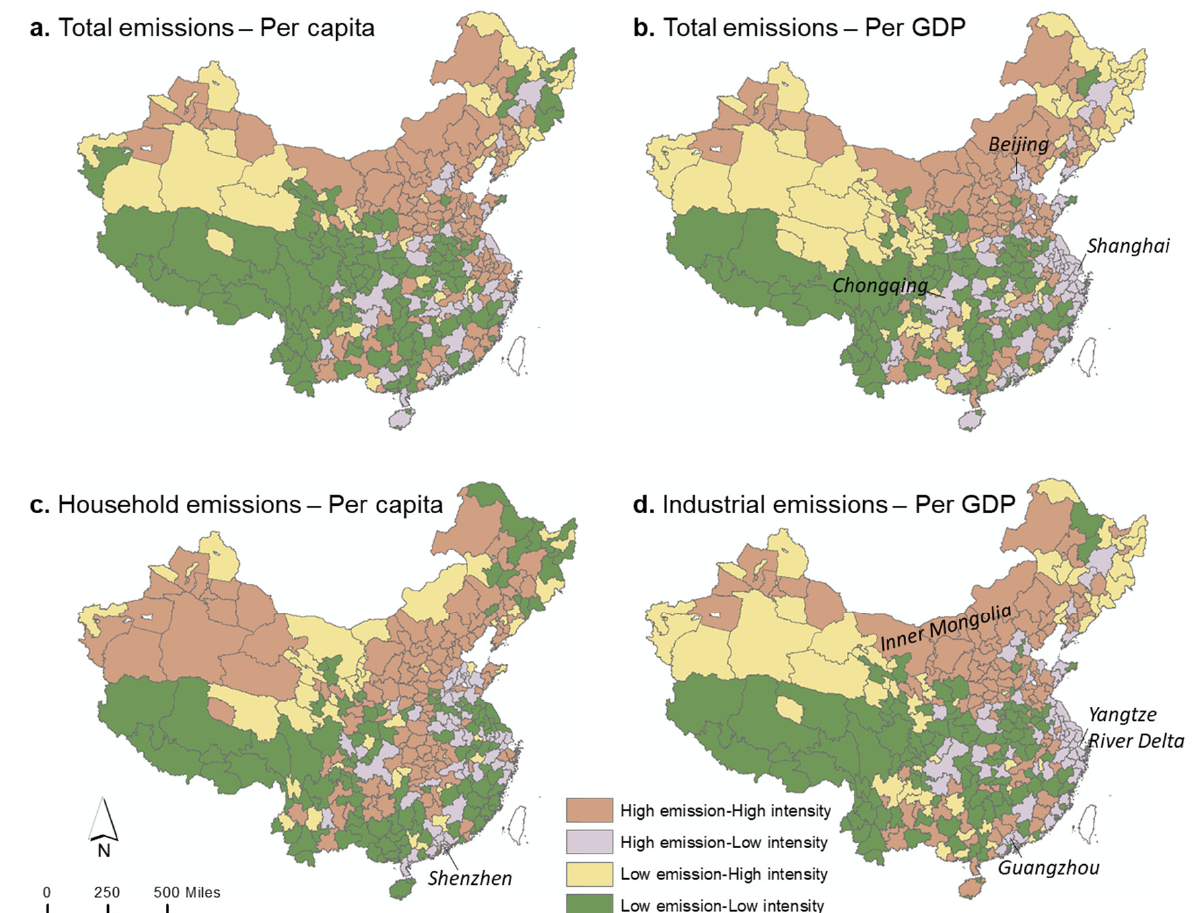
Figure 2. CO 2 emission types based on total emissions and the corresponding emission intensity. Taking household emissions per capita ( c ) as an example, the ‘high emission–high intensity’ refers to the cities with high household emissions and high per capita household emissions. The high/low was classified by the national median value.